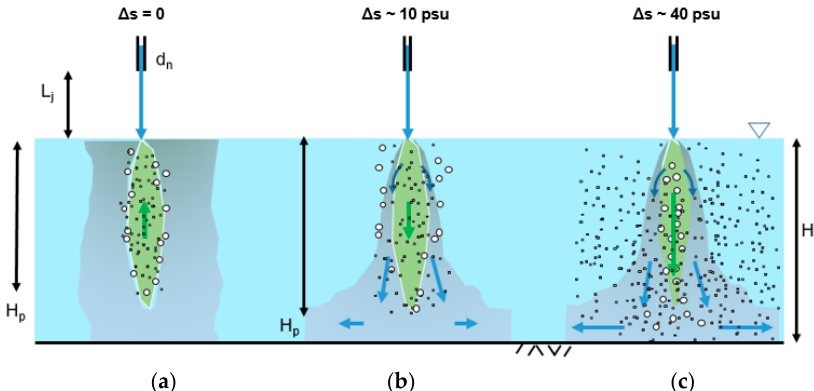
Figure 2. Schematic of ( a ) a neutrally buoyant plunging jet and ( b ) a negatively buoyant (dense) plunging jet with intermediate liquid density and ( c ) a negatively buoyant plunging jet with high liquid